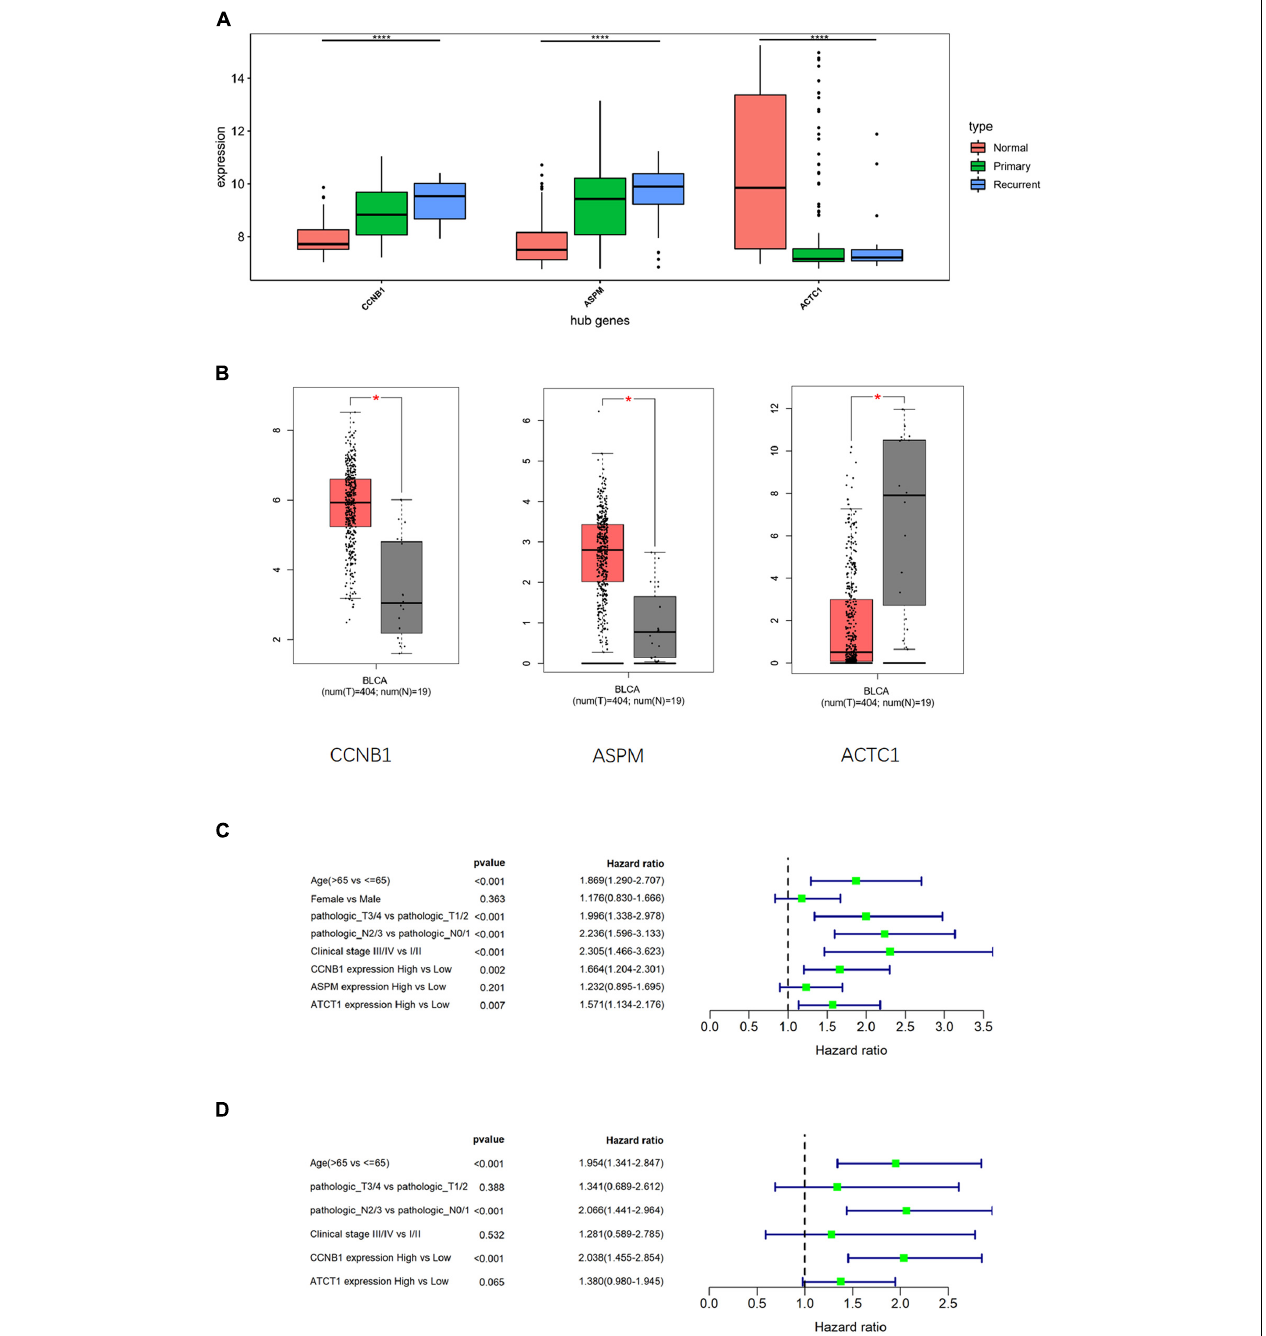
FIGURE 5 | Cox analysis compares the diagnostic potential of hub genes and clinical features in bladder transitional cell carcinoma (BTCC). (A) Analysis of hub gene expression in GSE13507 data set, in which the red box represents the normal group, the green box represents the primary tumor group, and the blue box represents the recurrent tumor group. The horizontal line in the box represents the median; the upper and lower edges of the box represent the upper and lower quartiles; the upper and lower edges of the whisker represent the maximum and minimum observed values; the points beyond the upper and lower edges of the whisker represent outliers. The difference is verified by ANOVA. (B) Analysis of hub gene expression in The Cancer Genome Atlas Urothelial Bladder Carcinoma (TCGA-BLCA) data set, in which the red box represents the tumor group, and the gray box represents the normal group. The horizontal line in the box represents the median; the upper and lower edges of the box represent the upper and lower quartiles; the upper and lower edges of the whisker represent the maximum and minimum observed values; the points beyond the upper and lower edges of the whisker represent outliers. The difference is verified by t -test. (C) Univariate Cox regression analysis was performed on clinical features and hub gene expression in TCGA-BLCA data set. (D) Multivariate Cox regression analysis was conducted for the clinical features and hub genes that were notably related to survival in TCGA-BLCA data set; * p < 0.05, **** p < 0.0001.